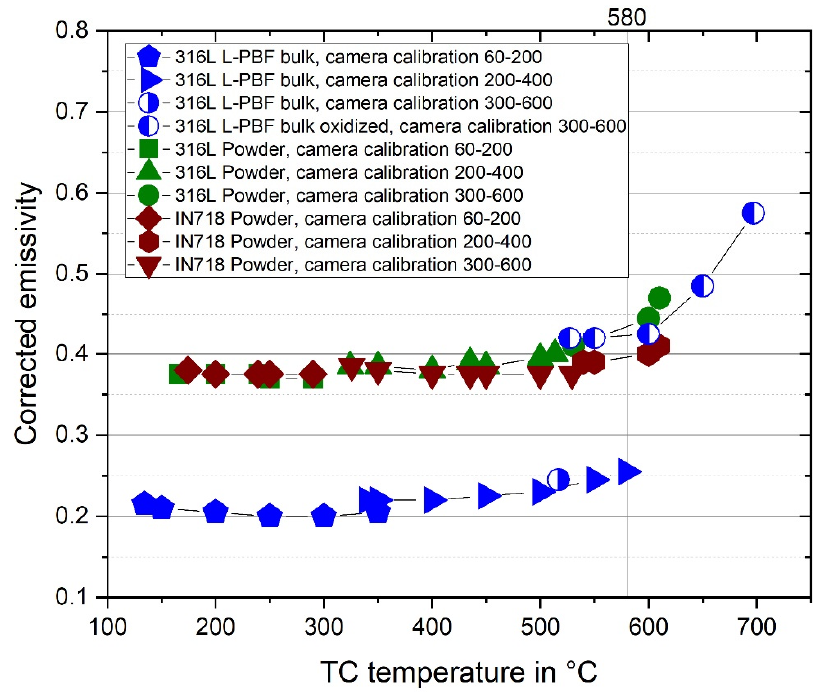
Figure 15. Corrected emissivity of 316L powder layer (green symbols) and of IN718 powder layer (brown symbols) and of 316L L-PBF bulk (blue symbols) over measured TC temperature.